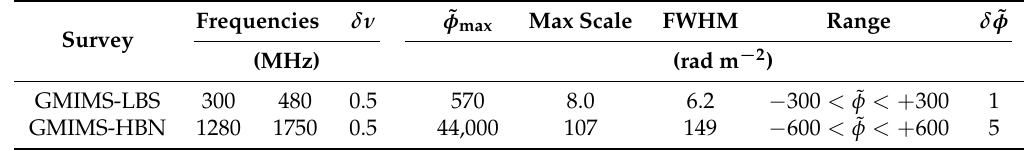
Figure 2. Spectrum of the polarization angle as a function of wavelength integrated over a beam (the sum of N = 25 sightlines) all the way through the noarm model, calculated on 0.5-MHz intervals. Cyan lines show the slope d ψ / d λ 2 = φ /2, as expected for a uniform slab, where φ = 37.1 rad m 2 is the mean Faraday depth integrated through all sightlines. Table 2. Rotation measure (RM) synthesis parameters. GMIMS, Galactic Magneto-Ionic Medium Survey; LBS, Low Band South; HBN, High Band